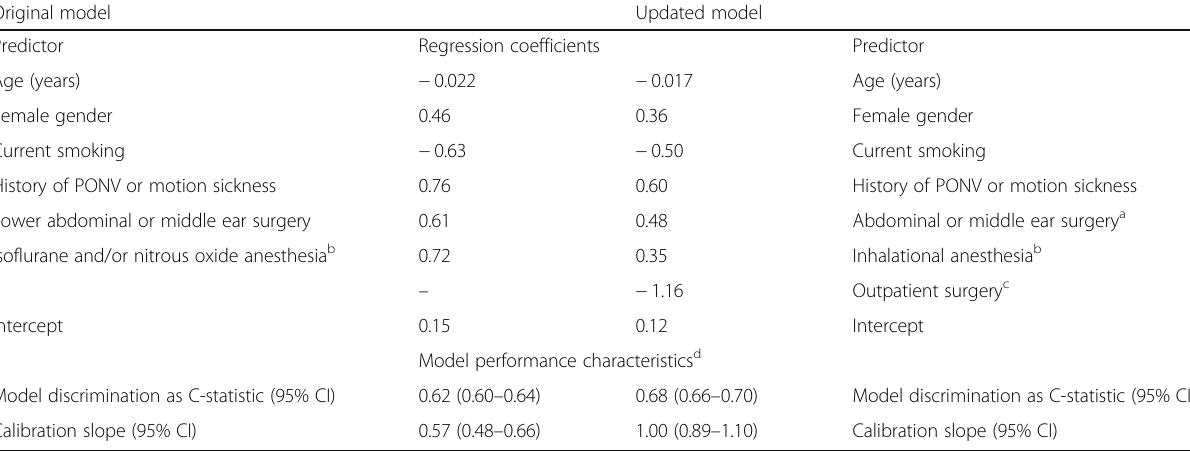
Table 1 Predictors and regression coefficients of the original and updated